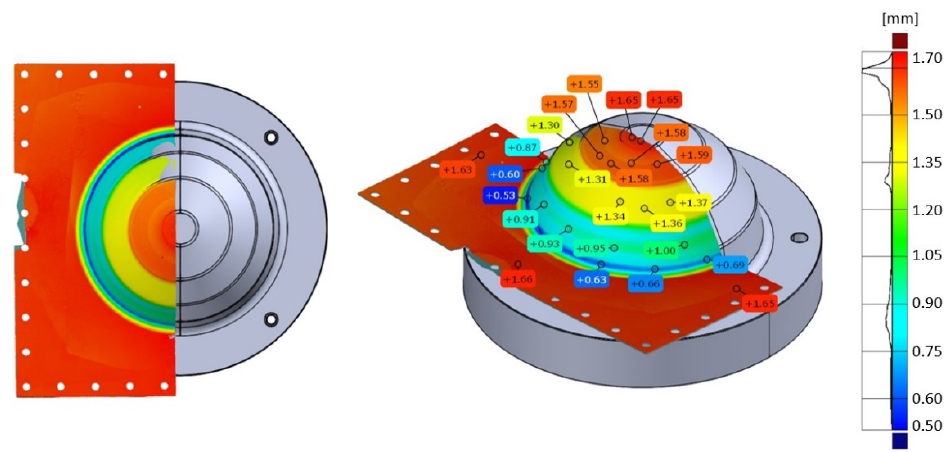
Figure 2. GOM scan to measure thickness reduction across SPIF formed part. Table 3. Thickness measurements from the scanned SPIF part to inform the necessary LMD thickening.